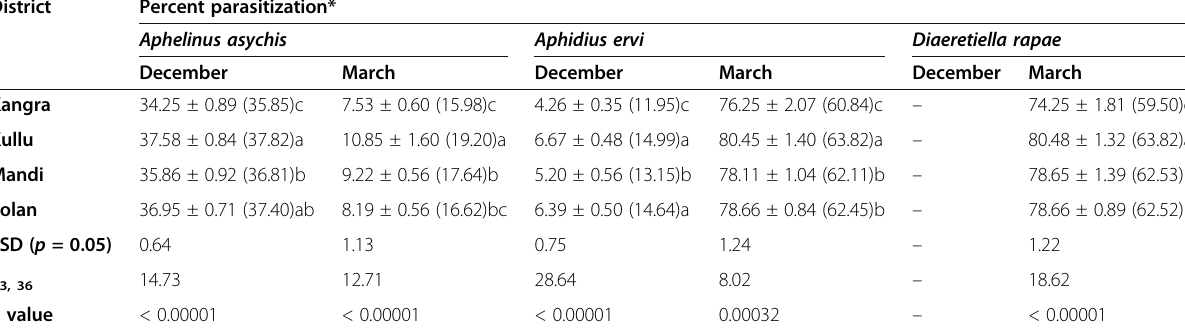
Table 1 Important parasitoids parasitizing of M . persicae in mid-hills of north India